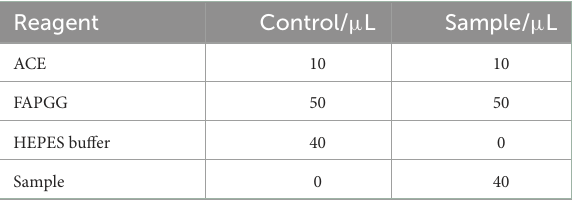
TABLE 1 Method for determination of angiotensin-converting enzyme (ACE) inhibitory